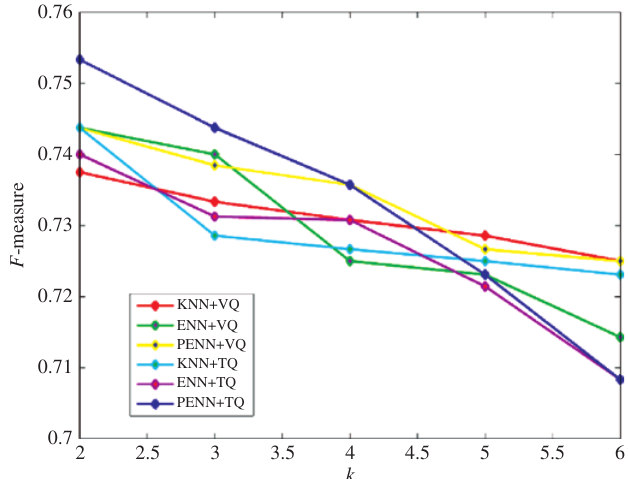
Figure 13: F -measure